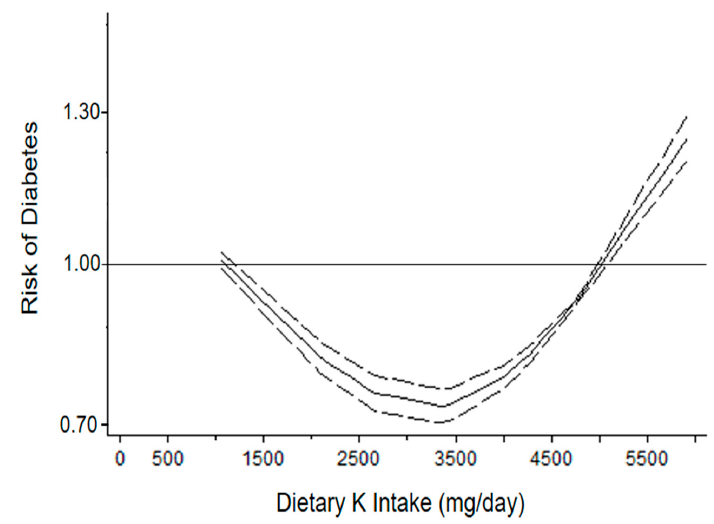
Figure 3. Dose–response association between dietary potassium (K) intake by urinary excretion and risk of diabetes (two cohorts). Urinary potassium excretion was modelled with restricted cubic splines in a multivariate random-effects dose–response model (solid line). Dashed lines represent the 95% confidence intervals for the spline model.